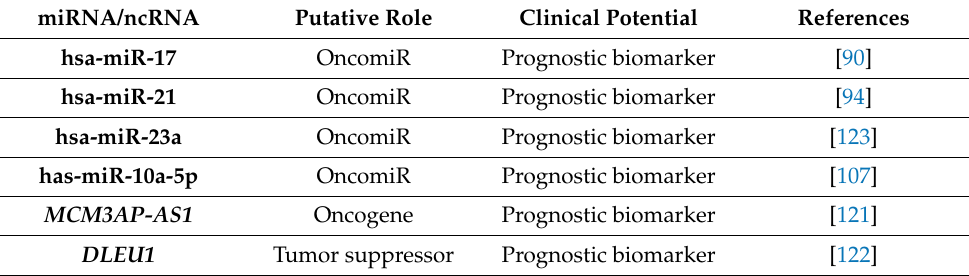
Table 2. Clinical potential of miRNAs/lncRNAs in